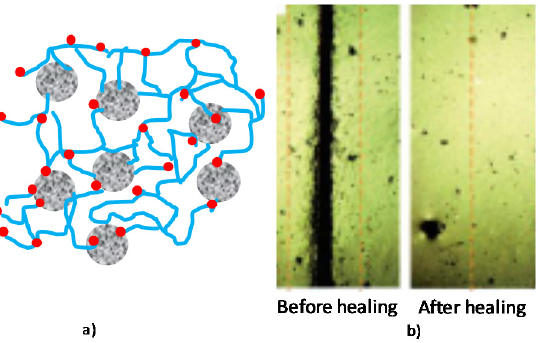
Figure 14. ( a ) The schematic of interaction of oligomer chains with μ Ni particles. ( b ) Optical image of scar healing for the damaged sample (adapted from [5]).